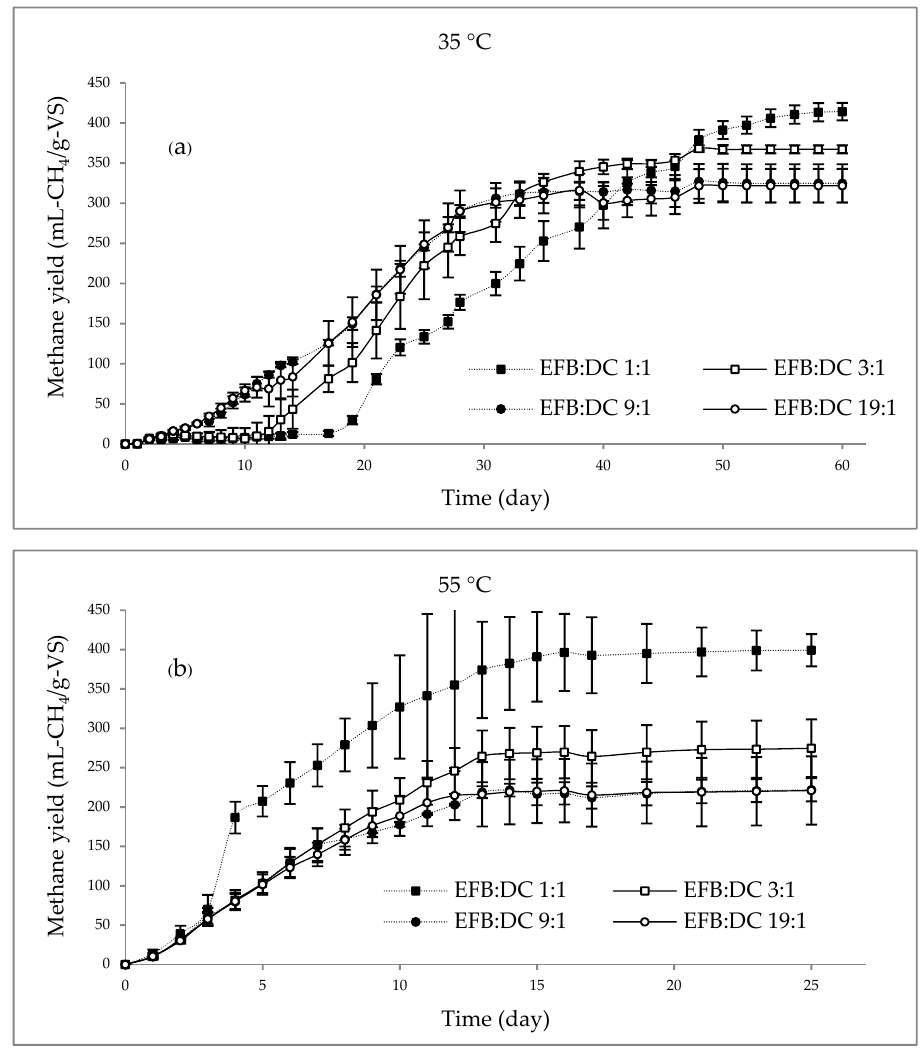
Figure 2. Methane yield achieved from different EFB : DC ratios for solid stage co - digestion with S : I ratio 3 : 1 at mesophilic temperature 35 °C ( a ) and thermophilic temperature 55 °C ( b ).